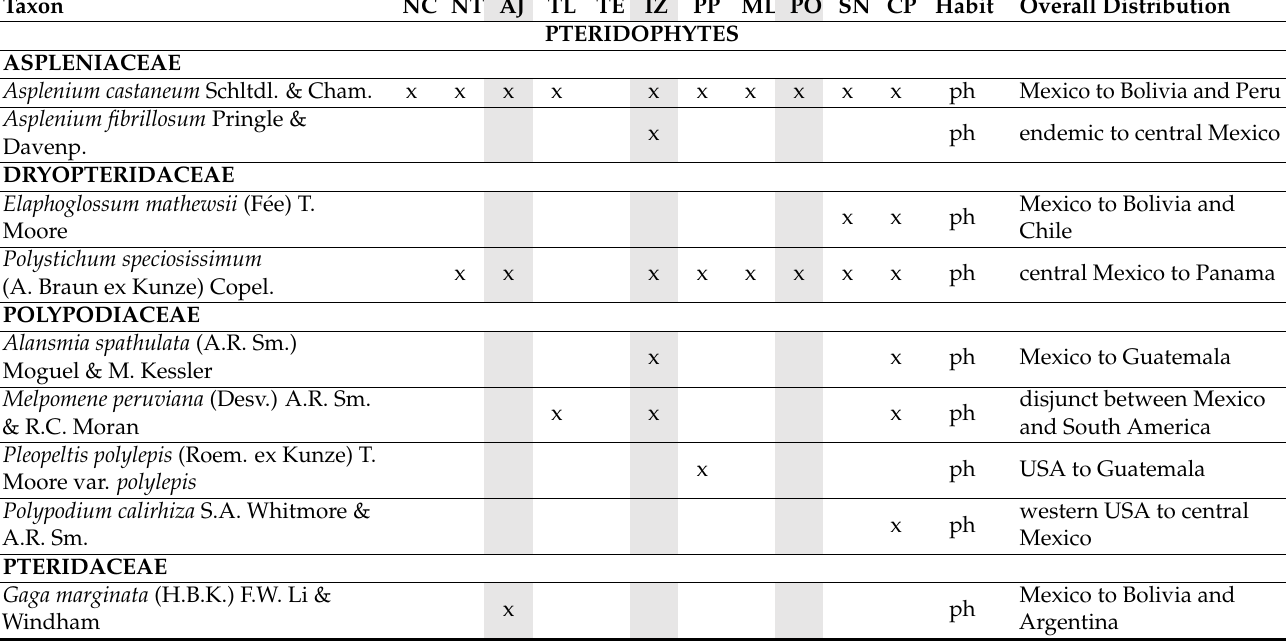
Table A1. Species list of the central Mexican alpine flora. * = Endemic to the study area; + = introduced. Occurence on the different volcanoes: AJ = El Ajusco (63), CP = Cofre de Perote (93), IZ = Iztacc í huatl (170), ML = La Malinche (62), NC = Nevado de Colima (31), NT = Nevado de Toluca (102), PO = Pico de Orizaba (78), PP = Popocat é petl (81), SN = Sierra Negra (46), TE = Telap ó n (57), TL = Tl á loc (72). Habit is as follows: an = annual herb, ph = perennial herb, sh = shrub, sub = subshrub, tr = tree. Overall distribution: TMVB = Trans-Mexican Volcanic Belt. Voucher information can be consulted in the Supplementary